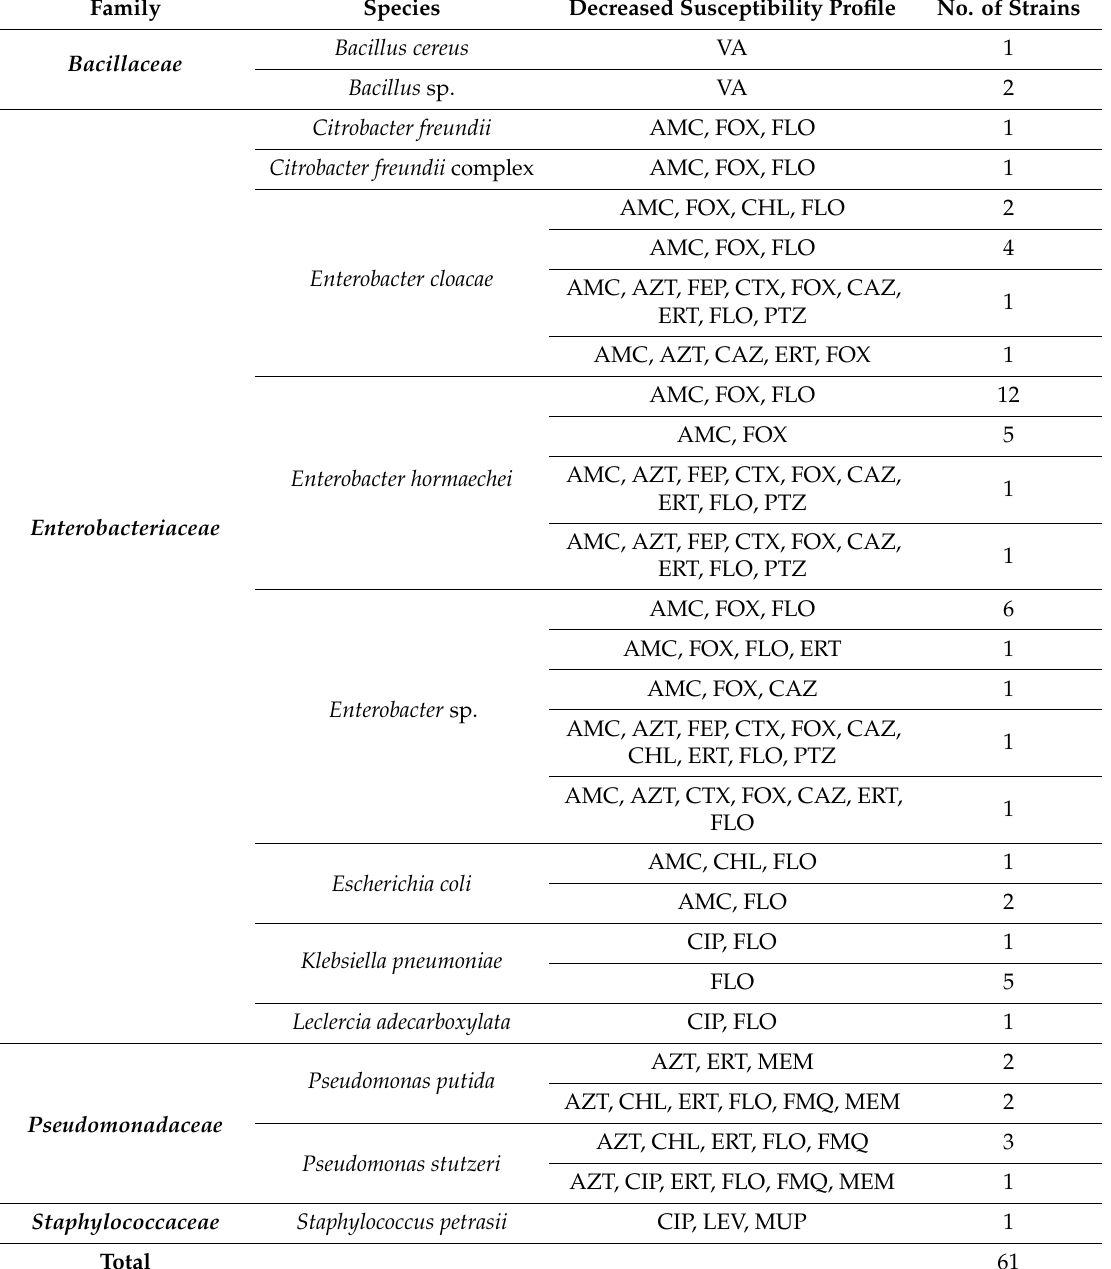
Table 8. Phenotype profile of the 61 strains that revealed decreased susceptibility to at least one antibiotic, including intrinsic